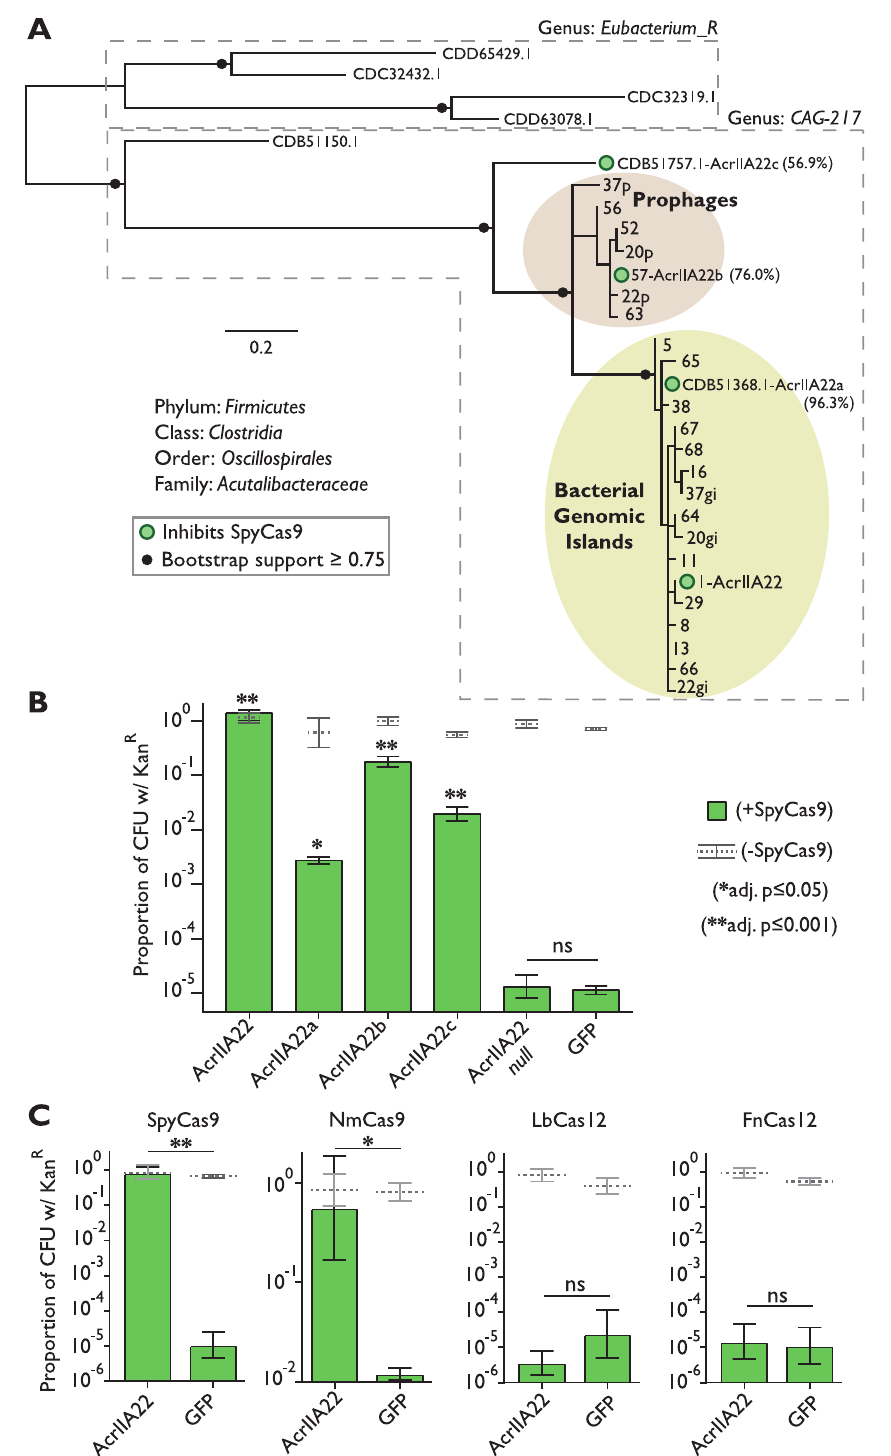
Fig 3. Several AcrIIA22 homologs in the CAG-217 clostridial genus can inhibit SpyCas9. ( A ) A phylogeny of all unique AcrIIA22 homologs identified from metagenomic and NCBI databases. Phylogenetic classifications were assigned corresponding to the GTDB naming convention (Methods). Prophage sequences are shaded brown and homologs from hypervariable bacterial genomic islands are shaded yellow. Sequences obtained from NCBI are labeled with protein accession numbers. In other cases, AcrIIA22 homologs are numbered to match their contig-of-origin